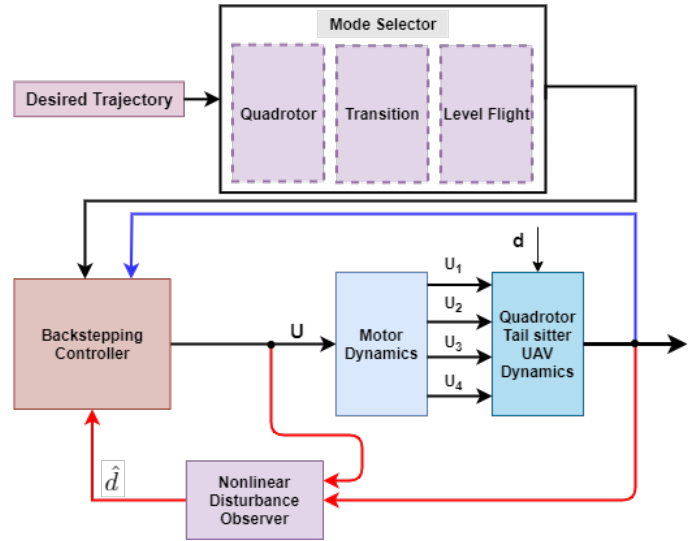
Figure 3. Controller Block